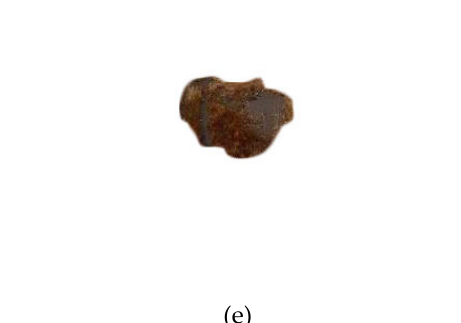
Figure 19. The segmentation results of oil pollution3 image. ( a ) 3DPCNN-HSOA; ( b ) LSA; ( c ) MS; ( d ) GLCM; and ( e )Ground truth.